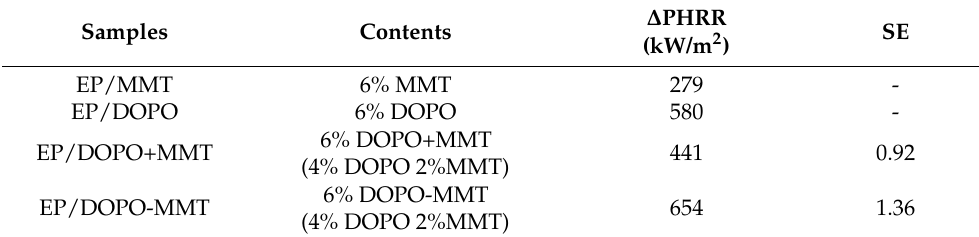
Table 5. Synergistic effectivity related to